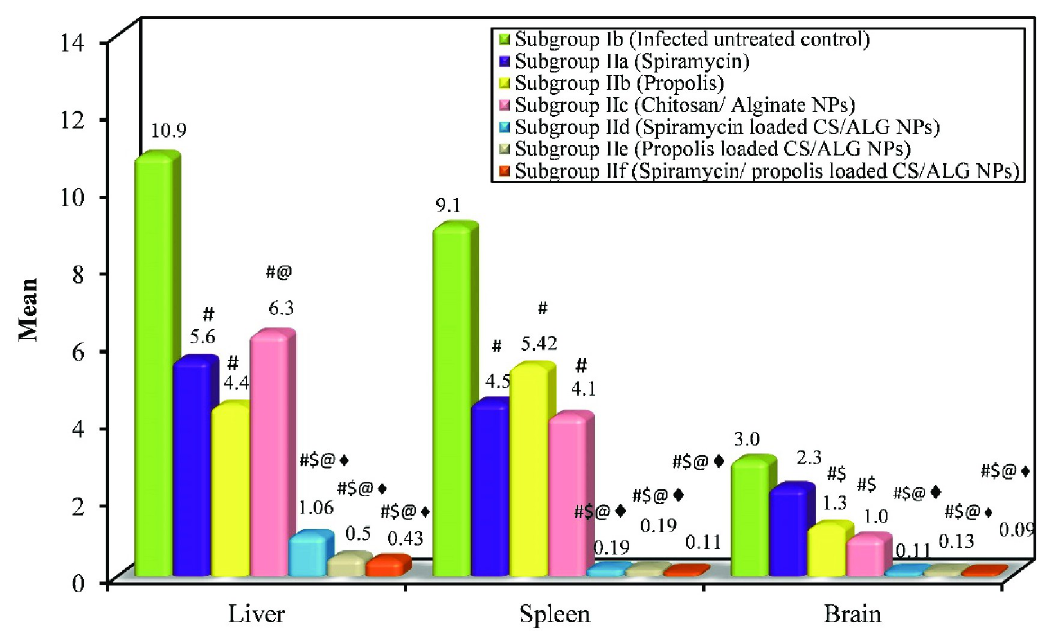
Fig 5. Comparison between the different studied subgroups according to the mean parasite count in liver, spleen and brain.